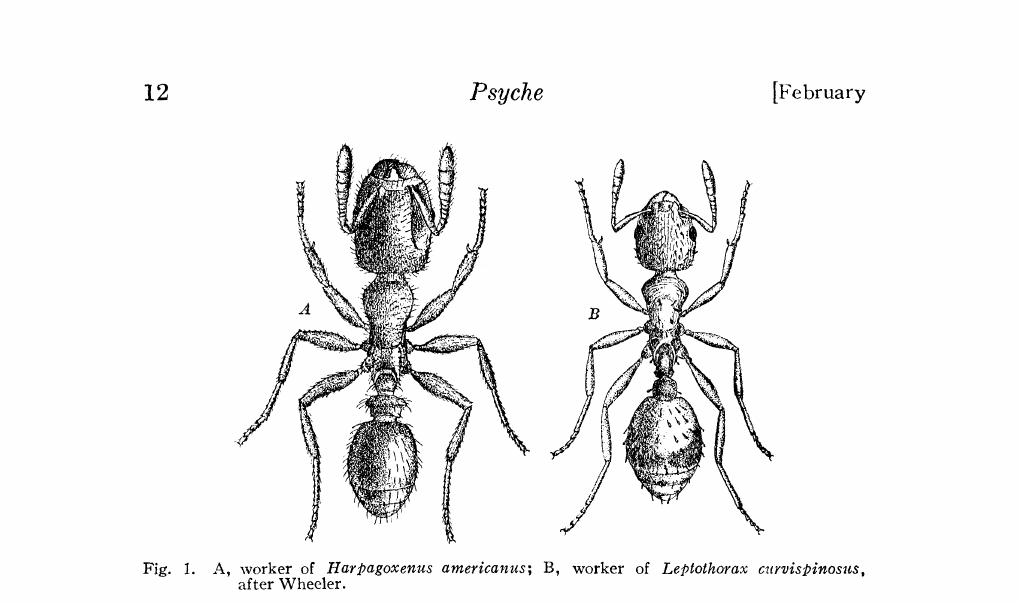
Fig. 1. A, worker of Harl>agoxenus americanus; B, worker of Leptothorax curvispinosus, after Wheeler. During the past summer I found a number of nests of